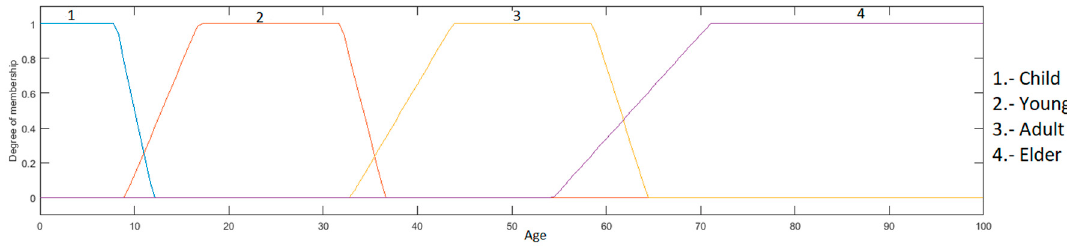
Figure 4. Input age.